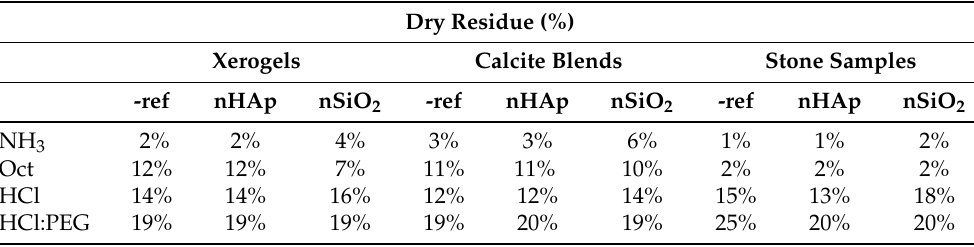
Table 3. Final dry residue (%) obtained in the three different drying environments ( ± 1%).